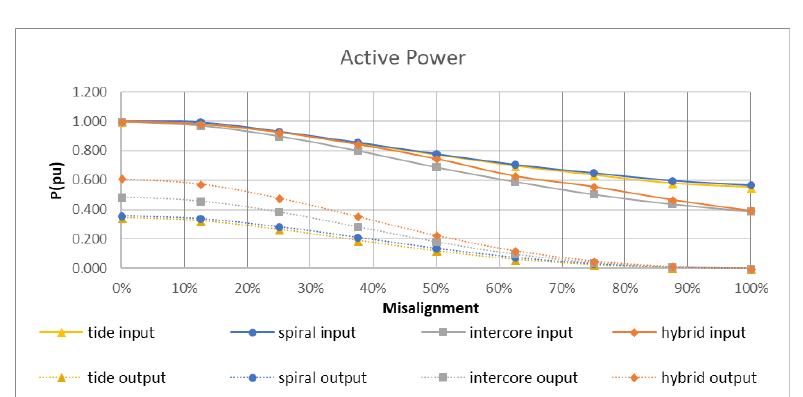
Figure 12. Simulation voltage.